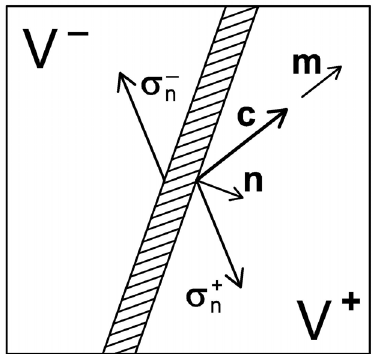
Figure 6: Body split by a potential discontinuity